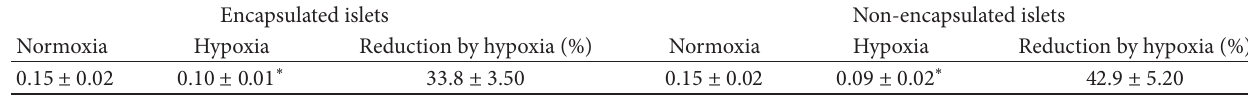
Table 2: Absorbance values (570 nm) representing islet viability measured by MTT.